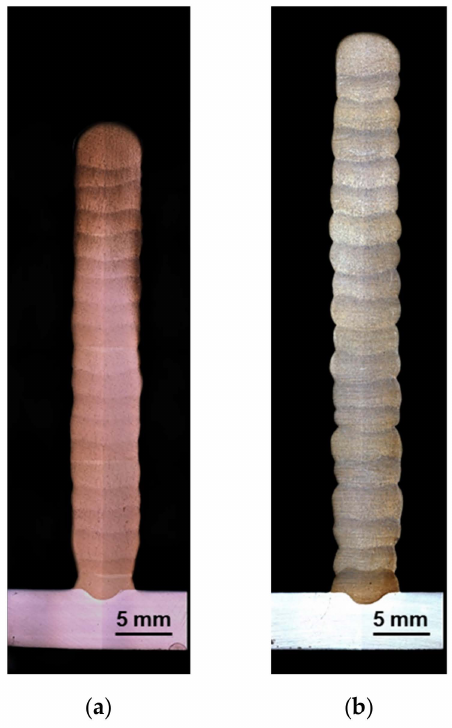
Figure 4. Geometry of specimens consisting of 20 layers each, ( a ) without cold wire, ( b ) with 23.1% cold wire